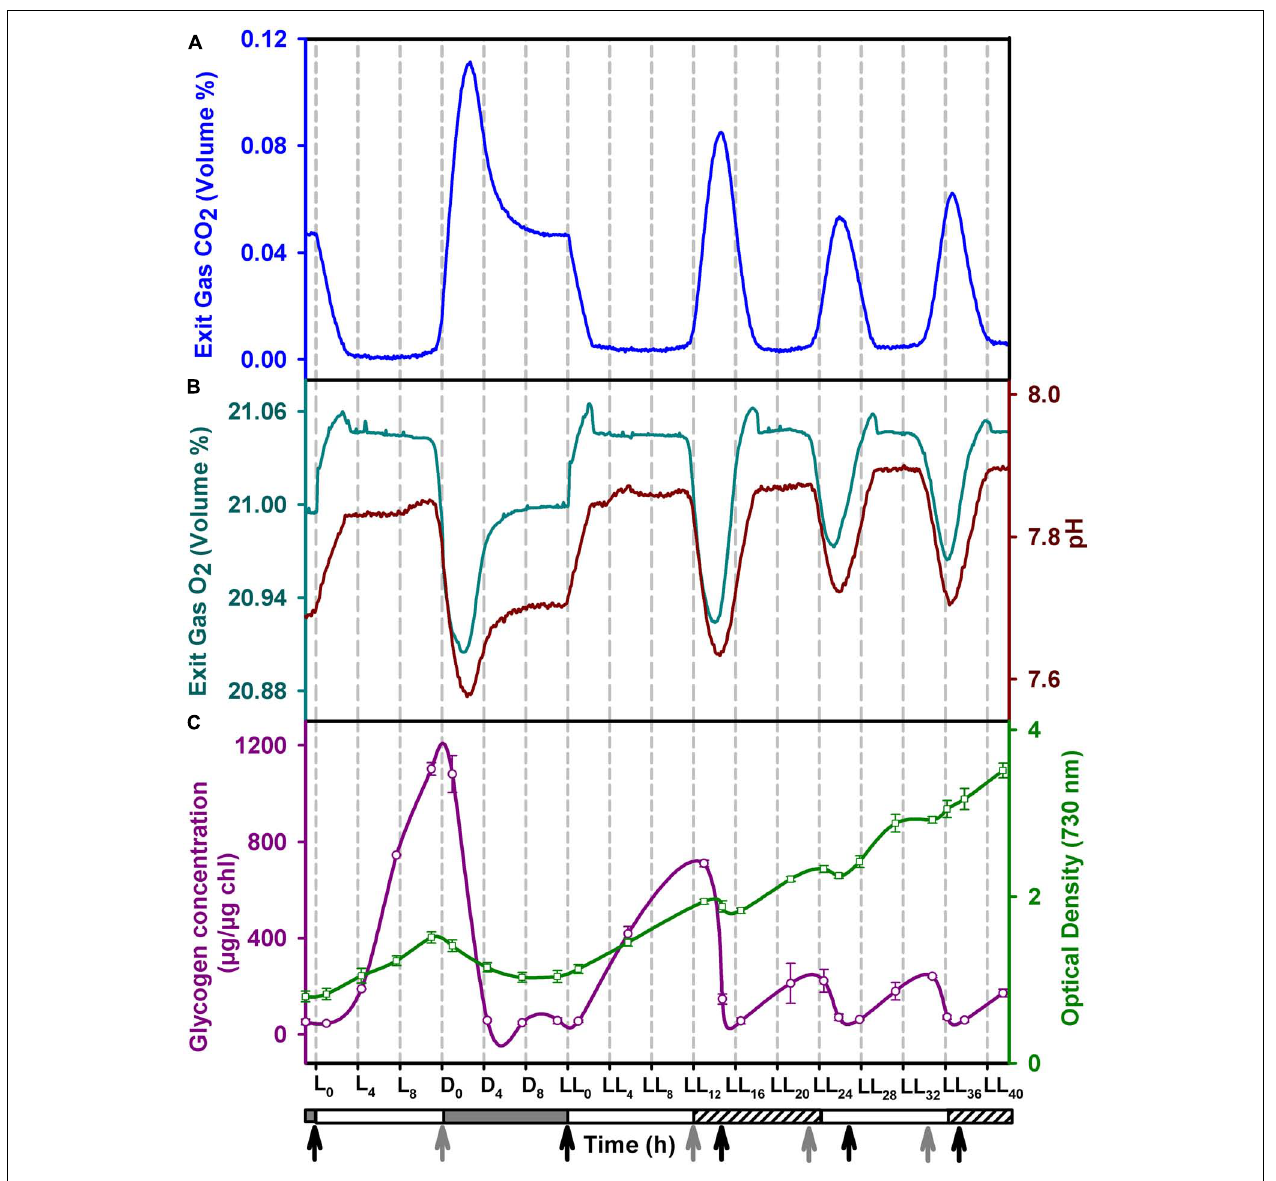
below the X -axis denotes the light (clear), dark (shaded) and subjective dark (shaded with slanted lines) phases.The onset of photosynthetic and respiratory phases are marked with black and grey arrows, respectively. Error bars on the glycogen and OD data points denote ± SEM for N =